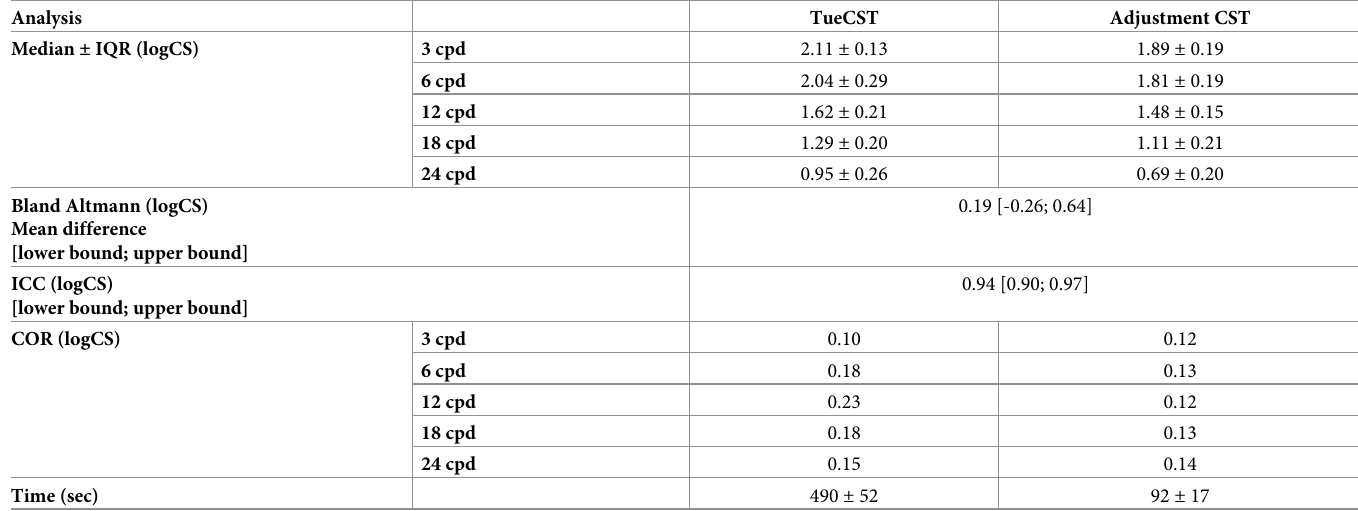
Table 1. Verification values of TueCST, Adjustment CST and Adjustment CST versus TueCST regarding median and interquartile range (IQR), agreement (Bland- Altman), reliability (Intraclass Correleation Coefficient (ICC)) and repeatability (Coefficient of Repeatability (COR)) all measured in logCS and time measured in sec (n = 5, except for 24 cpd: n = 4).